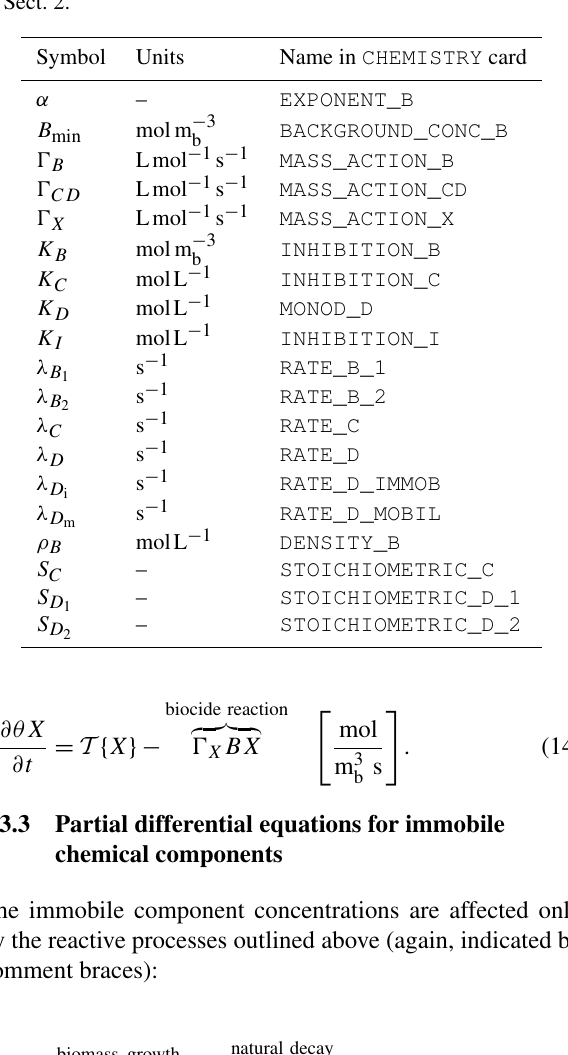
Table 2. Relationship between the parameter names in the CHEMISTRY card (Fig. A1) and the mathematical symbols shown in Sect.